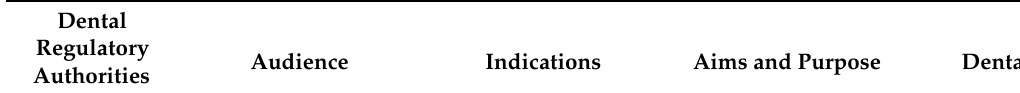
Table 2. Scope and characteristics of